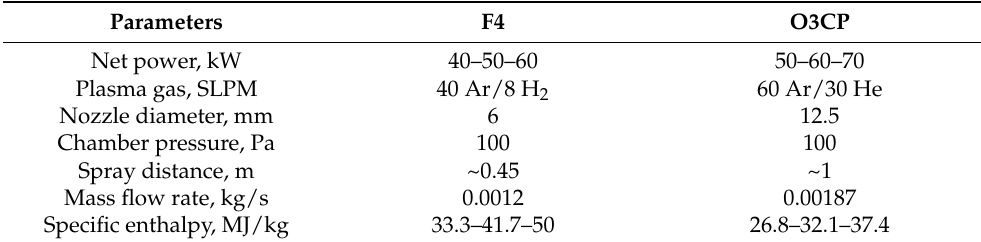
Table 1. Plasma torch model and operating parameters for the PS-PVD spray process used in this study. The torch net power is defined as the input electric power minus the heat losses to the electrode cooling